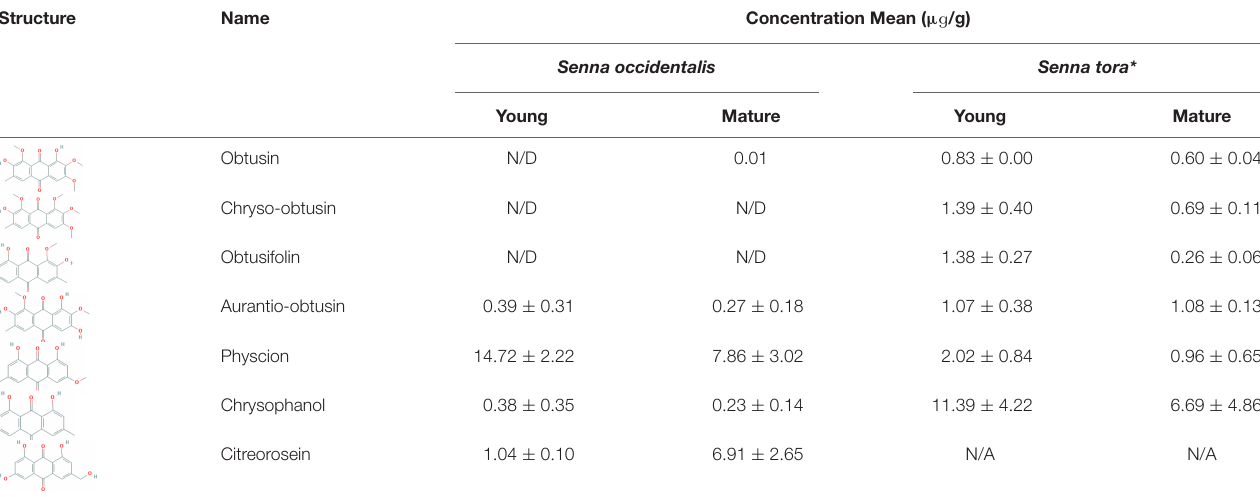
FIGURE 4 | MapMan metabolism overview maps showing differences in transcript levels between young- and mature-stage seeds. MapMan software was used to provide a snapshot of the modulated genes in the main metabolic pathways. Log 2 fold-change values are represented. Upregulated and downregulated transcripts are shown in red and blue, respectively. TABLE 2 | Summary of the anthraquinone derivative concentration between S. occidentalis and S. tora .